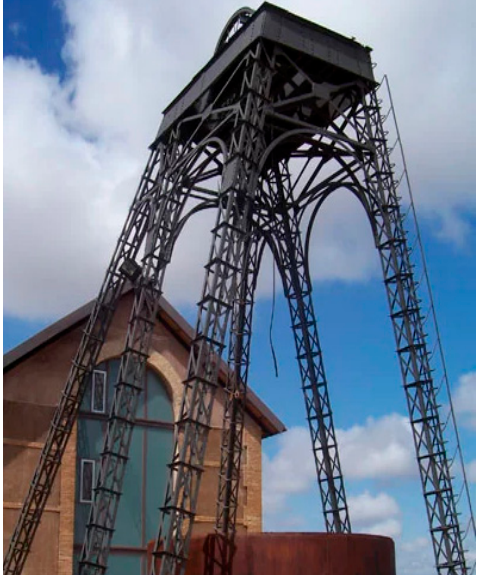
Figure 6. Shaft tower of the mining area. Municipality of Cartagena. Source: Sierra Minera Foundation [34].